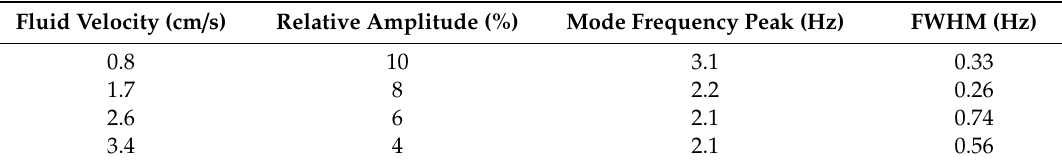
Table 2. Frequency analysis of the first mode associated to the current measurement at di ff erent mean velocities in the case of 1% TiO 2 -water